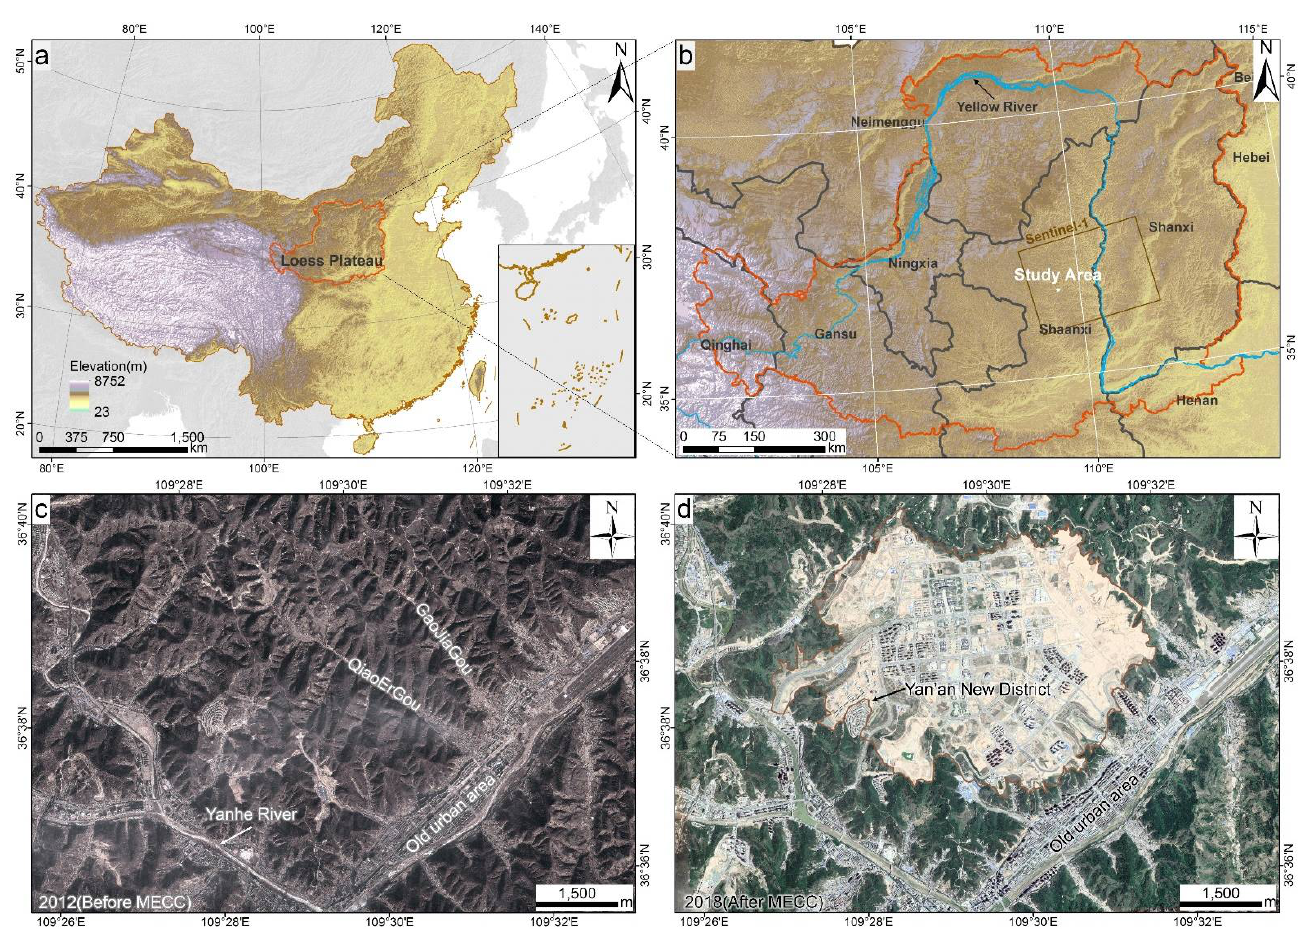
Figure 2. Administrative location of the study area. ( a ) Loess Plateau location; ( b ) study area location. The brown rectangle indicates the coverage of the selected Sentinel-1A images; ( c , d ) Google Earth images before and after the MECC project.